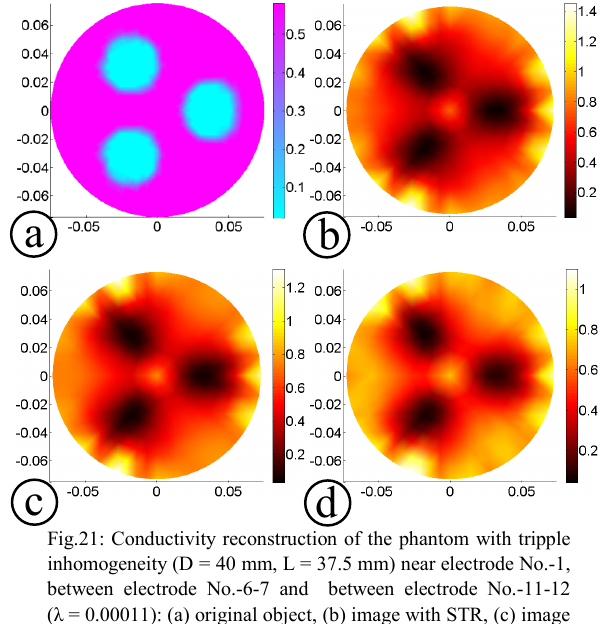
Fig. 21: Conductivity reconstruction of the phantom with tripple inhomogeneity (D = 40 mm, L = 37.5 mm) near electrode No.-1, between electrode No.-6-7 and between electrode No.-11-12 ( λ = 0.00011): (a) original object, (b) image with STR, (c) image with LMR, (d) image with BMMR